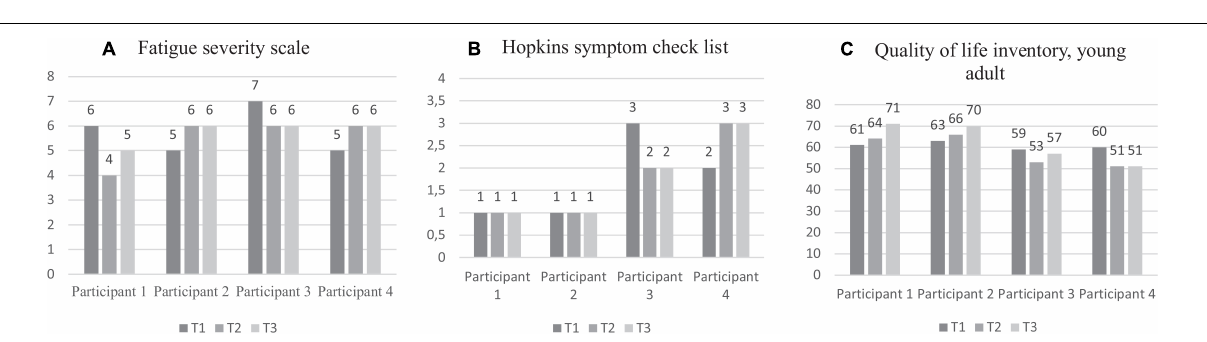
FIGURE 2 | Self-reported psychosocial health at preintervention, postintervention, and 6-month follow-up. (A) Mean scores as measured by Fatigue severity scale (FSS) are presented. Higher scores indicate higher fatigue. (B) Mean scores as measured by Hopkins’s Symptom Check List (HSCL-25) are presented. Higher scores indicate a higher symptom level. (C) Total summary health scores, as measured by the Quality of life inventory (PedsQLTM4.0), are presented. Higher scores indicate higher health-related quality of life